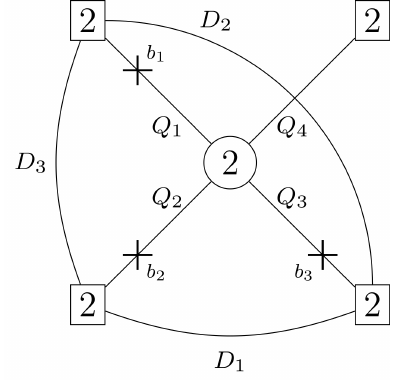
Figure 4 . Quiver diagram for the T 3